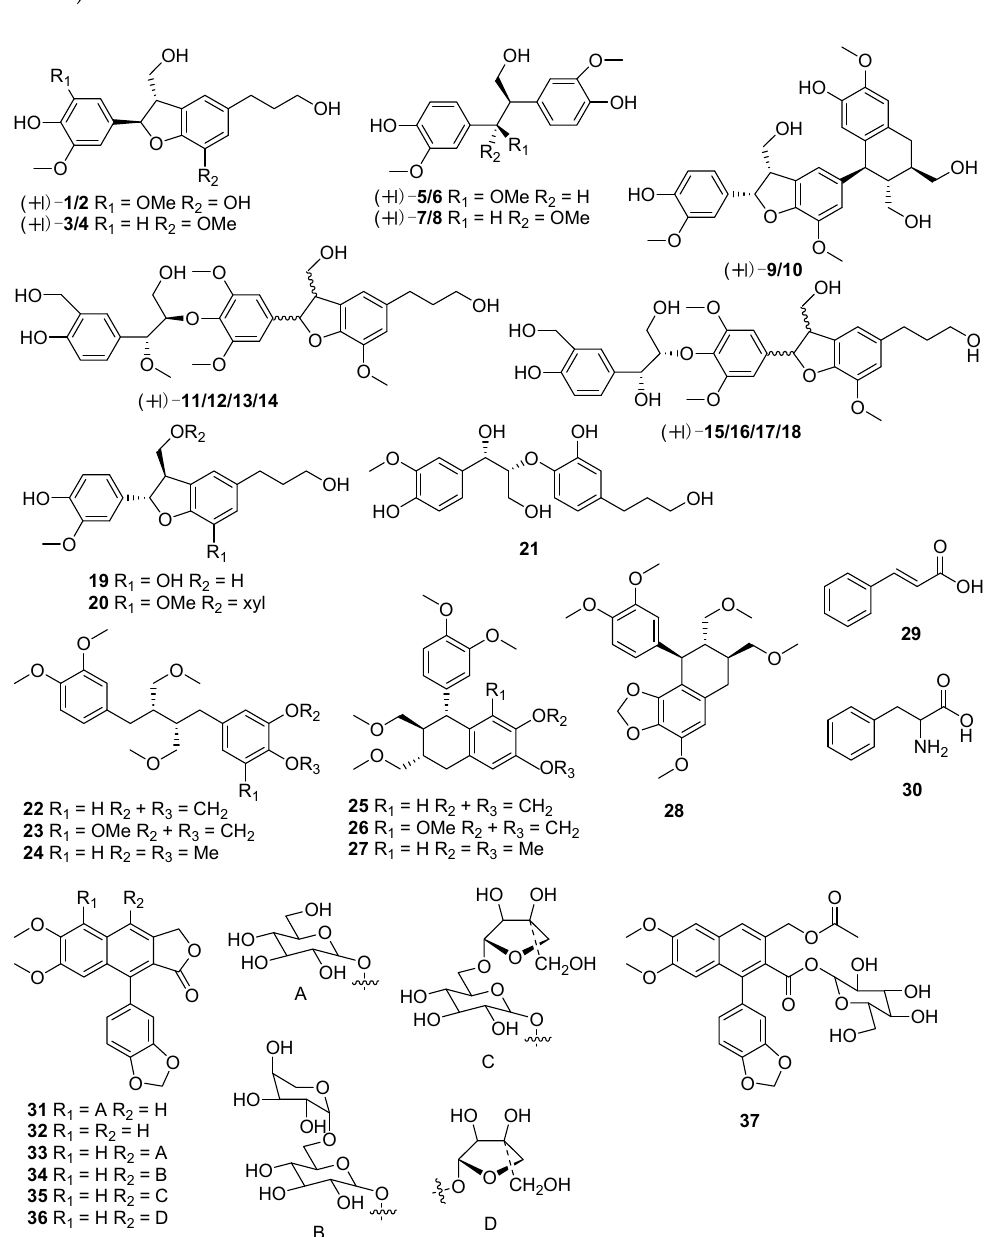
Figure 1. Phenylpropanoids from various Phyllanthus species.